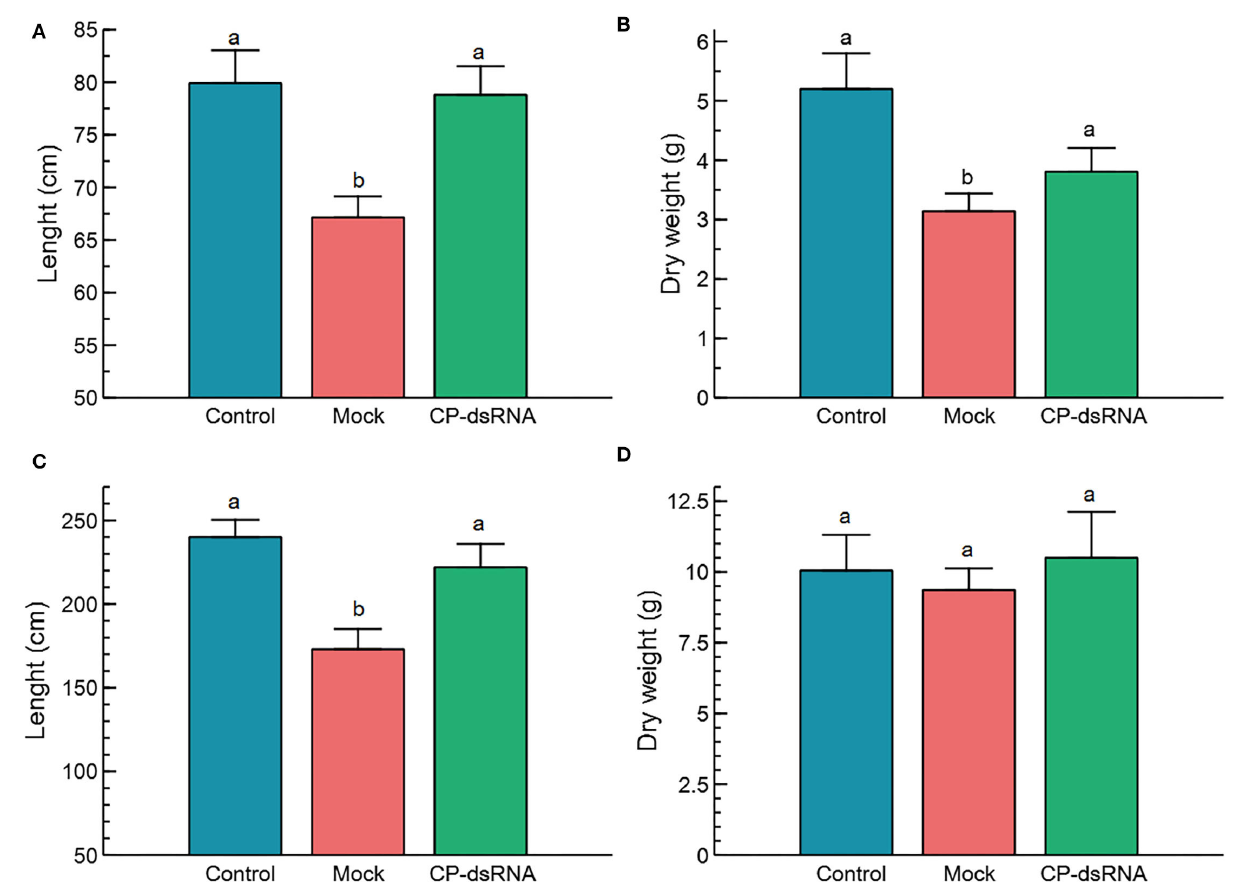
FIGURE 1 | Phenotypical parameters in the plants following cucumber green mottle mosaic virus (CGMMV) inoculation and CP-dsRNA treatment. Length (A) and dry weight (B) of the plants in the spring assay; (C,D) represent, respectively, the values of the length and dry weight obtained in the summer assay. Plants were evaluated at 18 days post-inoculation (dpi), when the symptoms in all the mock-treated plants were rated severe ( = 2) or very severe ( = 3). Control refers to non-inoculated plants. Bars correspond to the standard error of the means. Different letters on the columns refer to significant differences ( P <